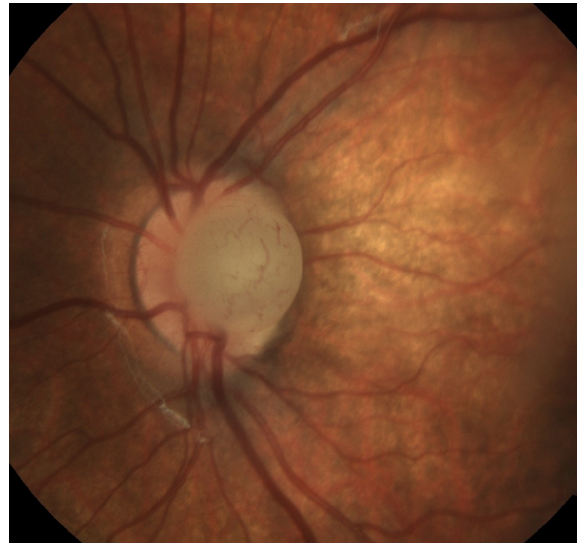
Figure 3: Fundus photograph showing the prepapillary